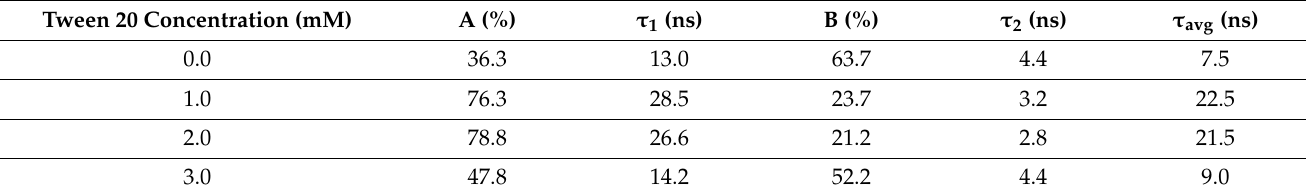
Table 1. Summary of the fast decay lifetime ( τ 1 ), the slow decay lifetime ( τ 2 ), and the average decay lifetime ( τ avg ) for MAPbI 3 perovskite